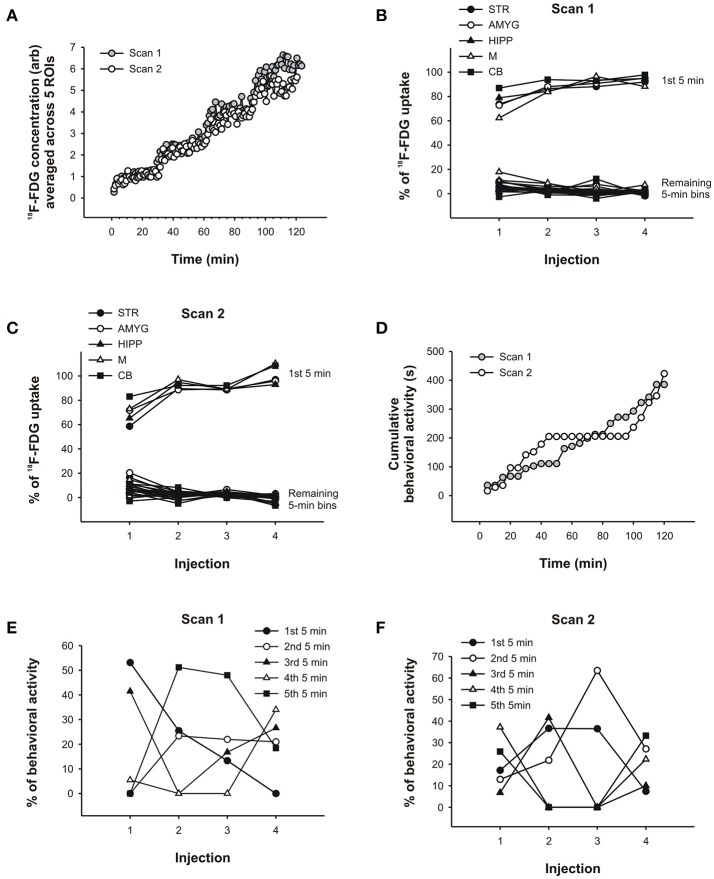
PET data and behavioral analysis for the rat. (A) Time-activity curves of scan 1 and scan 2 averaged across 5 ROIs, respectively. 18F-FDG uptake in (B) scan 1 and (C) scan 2 across successive 5min time bins in % of the total uptake during 25min following each injection of 18F-FDG.Most of the uptake occurred within the first 5min following each injection. These results were similar for all 5 brain regions examined. (D) Behavioral activity (s) was summed into 5min time bins and cumulated, that is, each successive 5min bin was added to the previous sum. In this way, a slope in the behavioral response curve indicates that the rat displayed activity, whereas flat regions indicate the absence of activity. The prolonged absence of activity starting at 45min in scan 2 coincides with the injection ofmorphine. Similar to the PET data analyses in (B,C), the behavioral activity of the rat in scan 1 (E) and scan 2 (F) was analyzed across successive 5min time bins in % of the total activity during 25min following each injection of 18F-FDG. The behavior was distributed across time in fairly unpredictable ways. STR, striatum; AMYG, amygdala; HIPP, hippocampus;M,motor cortex; CB, cerebellum.